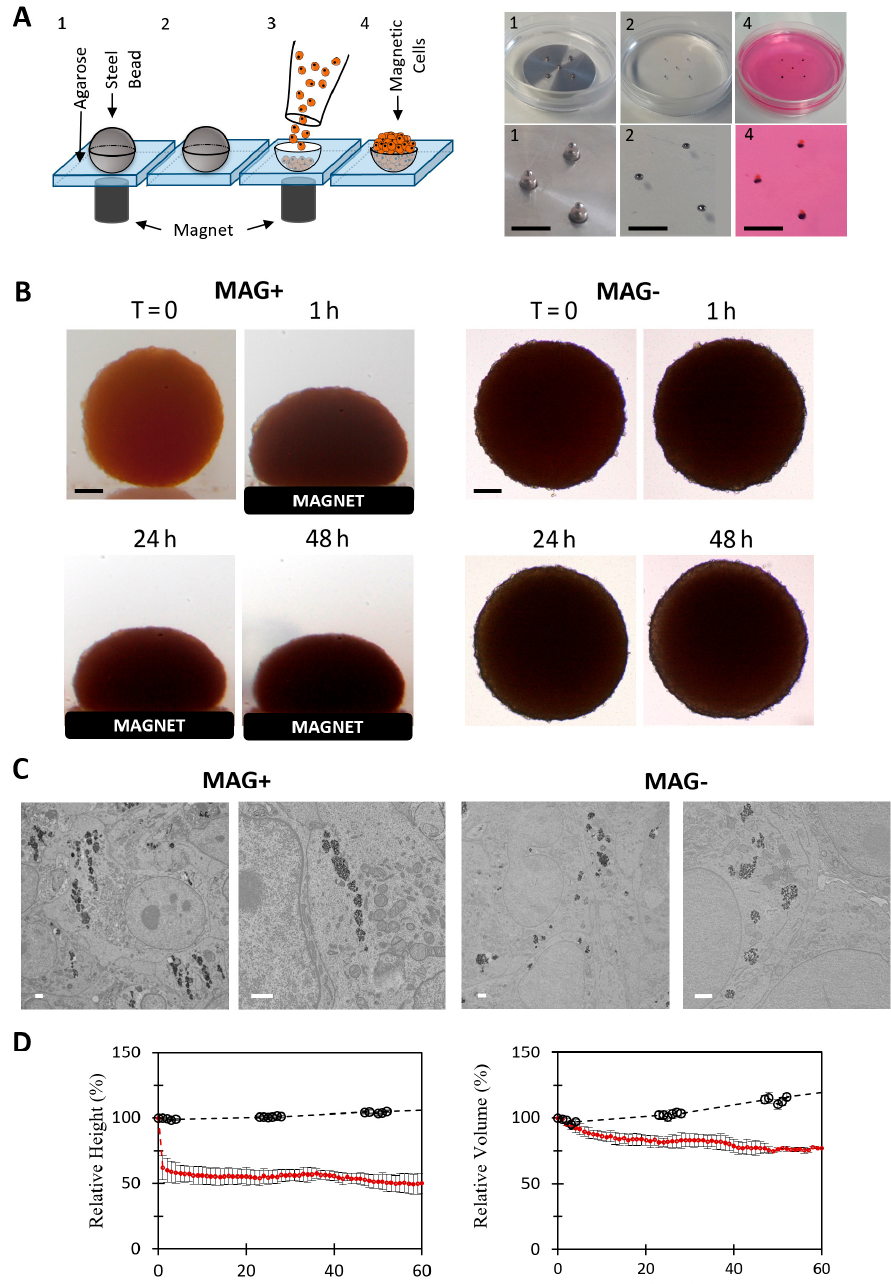
Figure 1. Magnetic formation (molding) and compression of CT26 spheroids. ( A ) Principle of spheroid magnetic molding, depicted with a scheme on the left and photographs on the right. Agarose molds (1 mm) were made using 1 mm magnetic beads (pictures 1 and 2). About 200,000 magnetically labeled CT26 cells were deposited on top of the molds and were attracted and aggregated within them by the cylindrical magnets placed below each mold. Aggregates were then matured overnight (picture 4). Scale bar = 5 mm. ( B ) Representative pictures of two molded aggregates. On the left, the spheroid was placed on a top of a permanent magnet (MAG+ condition). On the right, the spheroid grew without external stimulation (MAG − condition). For both, time-lapse images are shown. Scale bar = 200 µm. ( C ) Transmission electron microscopy of MAG+ and MAG − spheroids. The magnetic endosomes of the MAG+ spheroids are aligned along the field gradient, whereas in the MAG − condition, the endosomes containing nanoparticles are homogeneously distributed within the cell cytoplasm. Scale bar = 1 µm. ( D ) Temporal evolution of the relative height (left panel) and relative volume (right panel) of MAG+ (red curve, n = 9) and MAG − spheroids (black curve, n = 2). The magnetic compression results in a quick decrease in